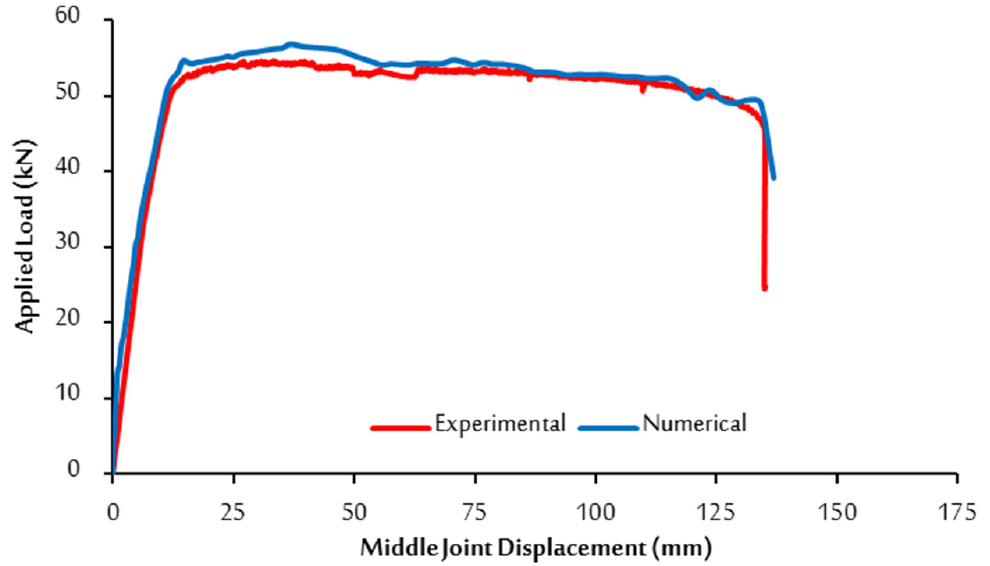
Figure 11. Comparison of the experimental and numerical load–displacement responses of the NC frames.